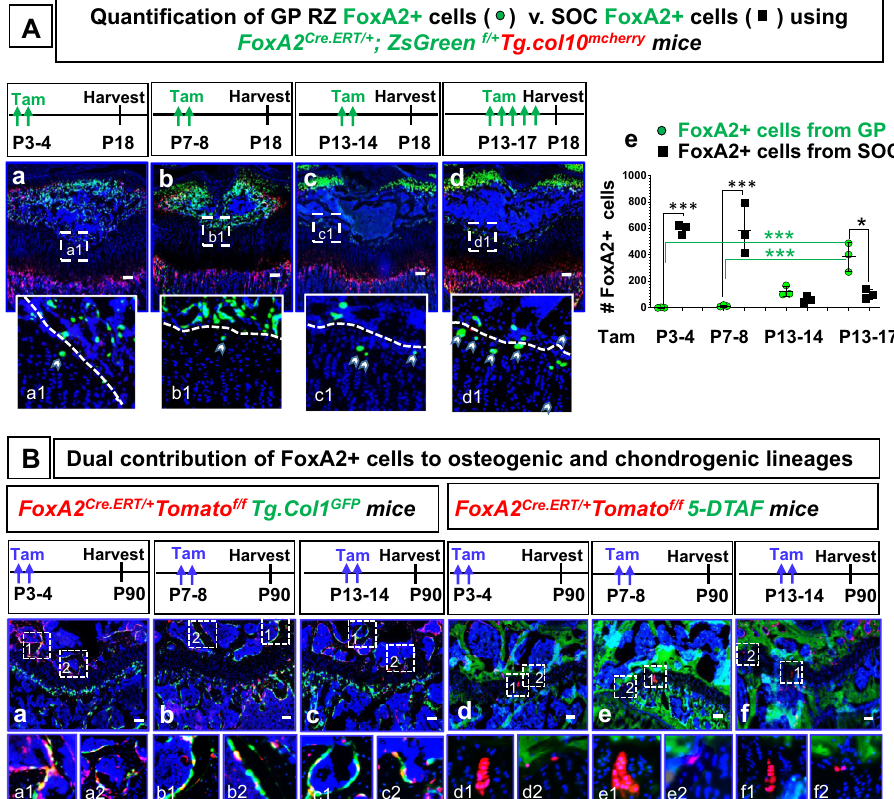
Fig. 2 A population of FoxA2 + col10 − cells pre fi gures SOC formation and gives rise to the top compartment of the GP RZ. A Tibia sections harvested from FoxA2 CreERT2/ + ;ZsGreen fl / + ; Tg.Col10 mcherry mice treated with 2x tamoxifen (Tam) injections at postnatal days P3-4 ( a ), P7-8 ( b ), P13-14 ( c ), or 5x tamoxifen injections P13-P17( d ), and harvested at P18. Hoechst (blue), ZsGreen fl uorescence microscopy (green), mcherry fl uorescence microscopy (red). Scale bars, 100 µ m. Representative details, from the interface between GP and SOC, are shown in numbered insets ( a1 – d1 ). Quanti fi cation of the number of FoxA2 + (ZsGreen + ) cells in GP is achieved by counting ZsGreen + cells located in GP (extending 100 µ m away from the GP/SOC interface, towards the GP). The number of ZsGreen + cells represents a sum of n = 8 sections per mouse hindlimb. Similar quanti fi cation is performed for FoxA2 + cells in SOC. Data presented as mean ± SD, n = 3 mice. The asterisks indicate signi fi cant difference: One-way ANOVA, Tukey test; *** p = 0.000003 (P3-4 GP vs P3-4 SOC), 0.000005 (P7-8 GP vs P7-8 SOC), 0.000569 (P3-4 GP vs P13-17 GP), 0.000828 (P7-8 GP vs P13-17 GP), and * p = 0.011031(P13-17 GP vs P13-17 SOC). Complete statistical information is provided in Supplementary Table 1 ( e ). B Tibia sections from FoxA2 CreERT2/ + ;Tomato fl / + ;Tg.Col1 GFP mice treated with 2x tamoxifen injections P3-P4 ( a ), P7-P8 ( b ), P13-P14 ( c ), and harvested at P90. Tibia sections from FoxA2 CreERT2/ + ;Tomato fl / + mice treated with 2x tamoxifen injections P3-P4 ( d ), P7-P8 ( e ), P13-P14 ( f ), harvested at P90. Tomato (red), Hoechst (blue), GFP (green) ( a – c ), 5-DTAF (green) ( d – f ). Scale bars, 100 µ m. Representative details are shown in numbered insets ( a1 – f1